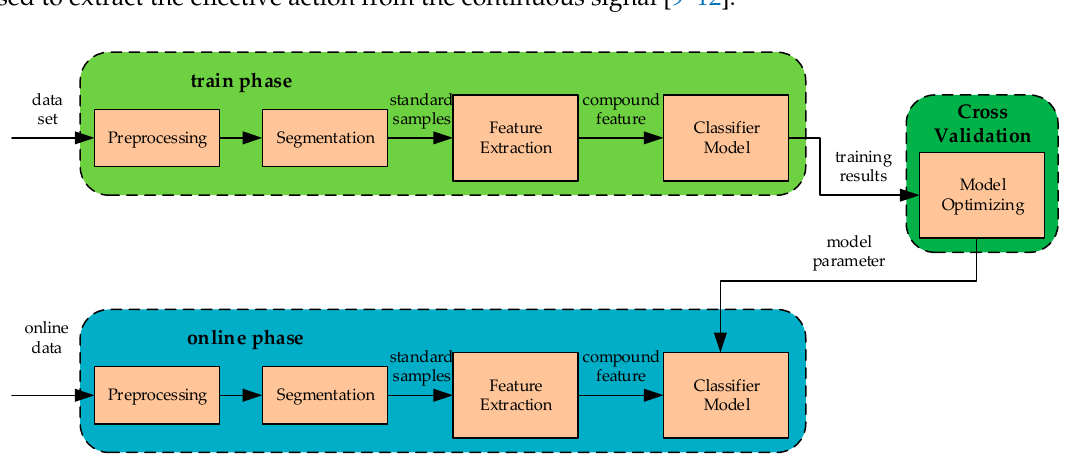
Figure 3. Segmentation–recognition mechanism signal flowchart. There are two parts in this flowchart: offline data processing with model training and online data processing with SLR.